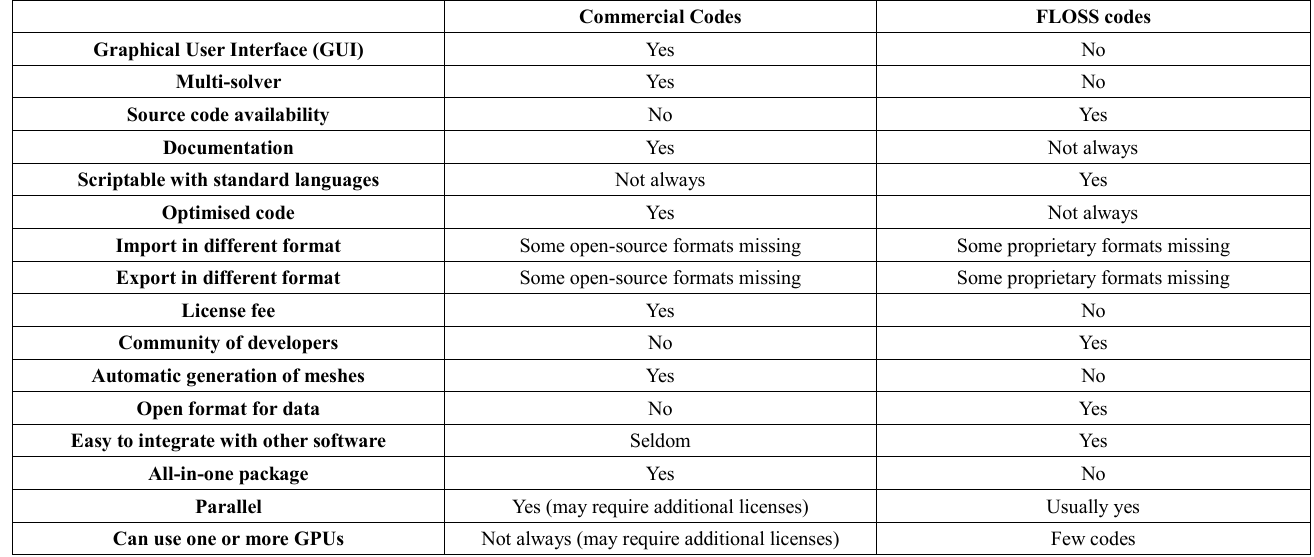
C OMPARED F UNCTIONALITIES OF C OMMERCIAL AND FLOSS S IMULATION C